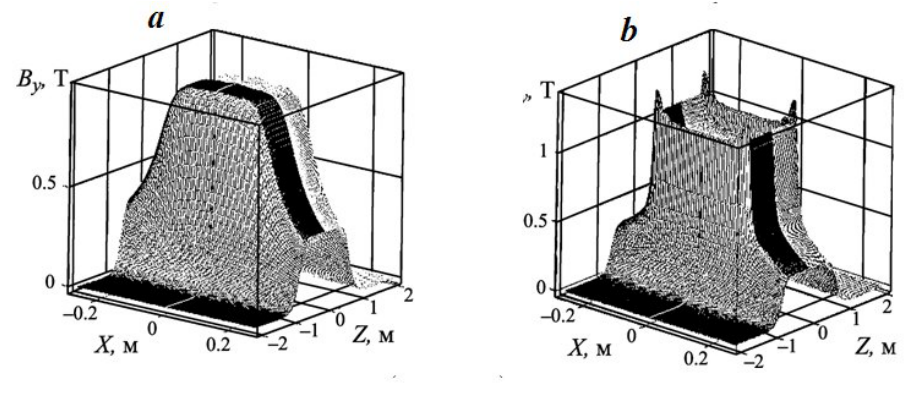
Figure 3. For a current I = 328 A: 3d-distribution B y ( x ,y = 0 , z ) for the median plane y = 0 (a);